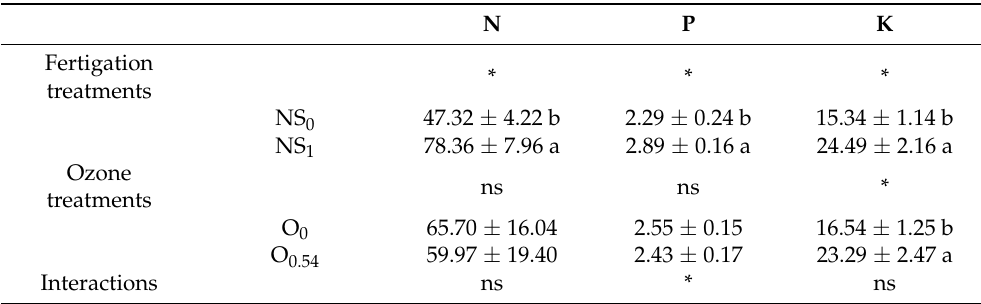
Table 9. Effect of fertigation and ozone on nitrogen, phosphorous, and potassium leaf concentration (mg g − 1 DW). The data recorded are the means ± standard deviation of four samples per treatment at the end of the experimental period. In each column, different letters or an asterisk (*) denote statistically significant changes between treatments (LSD test; p < 0.05). ns indicates non-statistical differences between